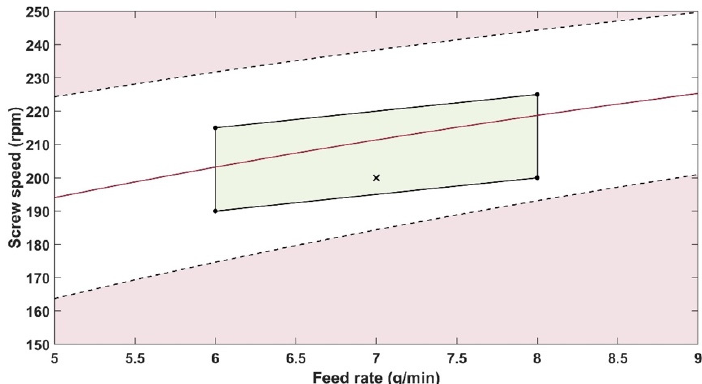
Figure 14. Contour profiler showing the influence of the interaction of screw speed and feed rate on the predicted PRX amount using the PLS model. The red line indicates the predicted PRX content of 14.45% w / w . The black cross marks the optimised extruder parameters. The black dashed lines indicate the upper and lower limits defined respectively 14.75 and 14.15% w / w of PRX.